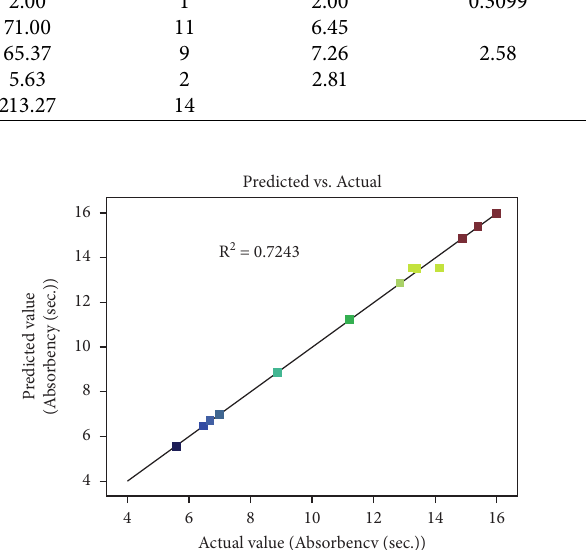
Figure 1: Correlation between the actual value and predicted value of the absorbency of the fabric.